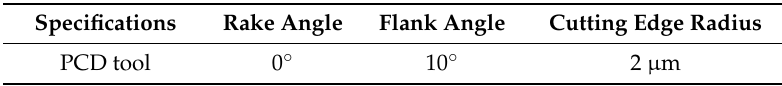
Table 1. Specifications of the polycrystalline diamond (PCD) tool.